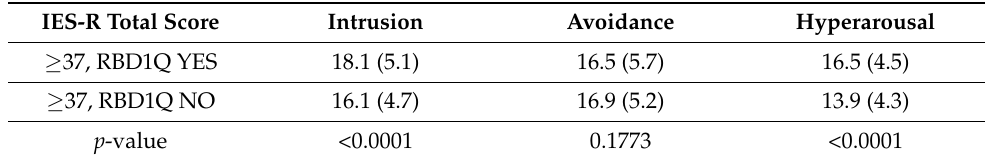
Table 5. Sub-scores in intrusion, avoidance and hyperarousal in participants who answered yes and no on the RBD1Q with total IES-R scores ≥